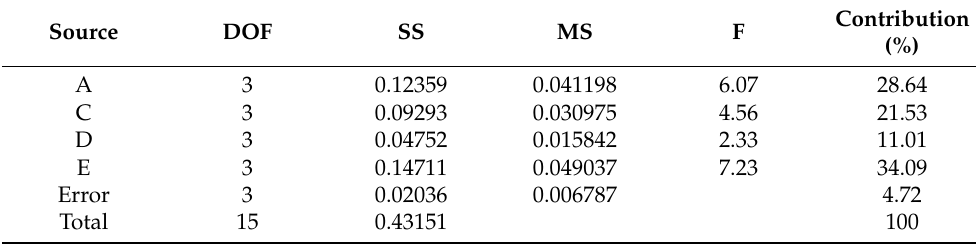
Table 8. ANOVA for the GRG